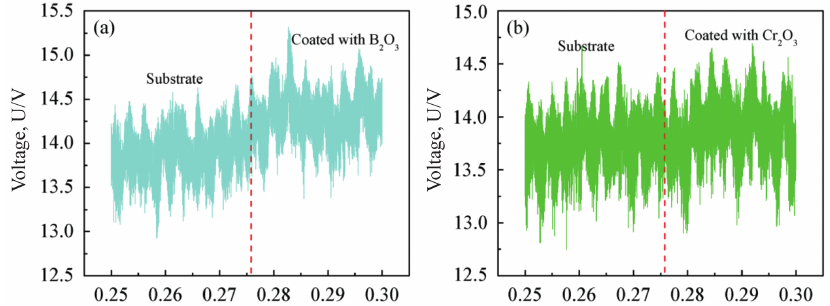
Figure 3: Measured result of arc voltage: (a) A-TIG with B 2 O 3 ; and (b) A-TIG with Cr 2 O 3